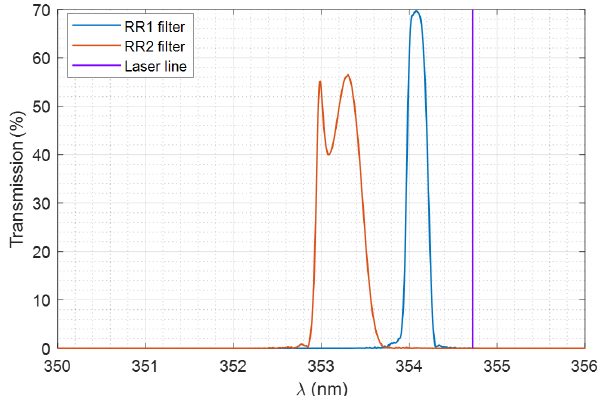
Figure 6. RR filter spectral transmittance measured with an optical spectrum analyzer with illumination by a 340nm LED: RR1 (low-J) and RR2 (high-J) filter at 0 ◦